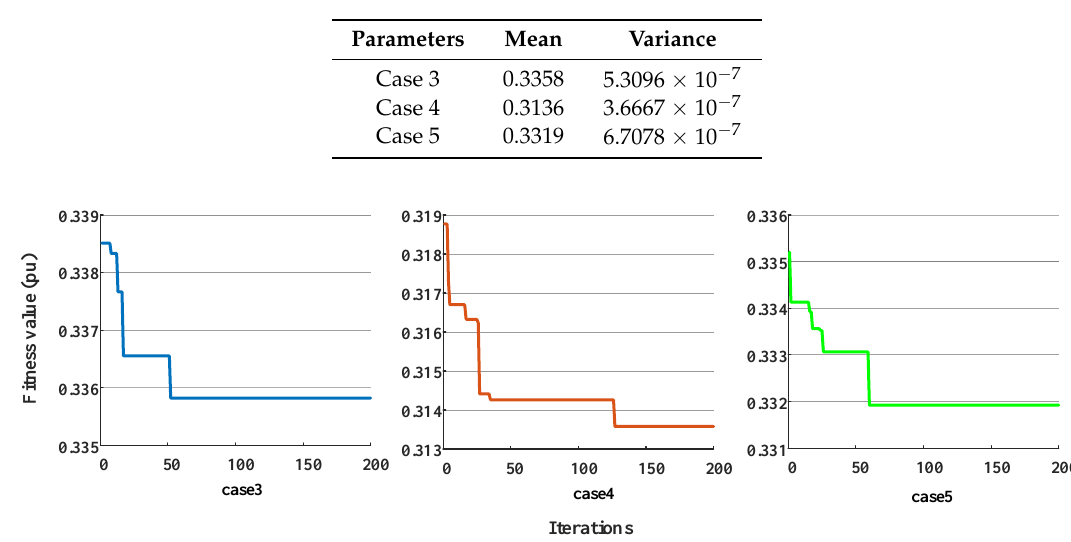
Table 6. The objective function value of PSO.